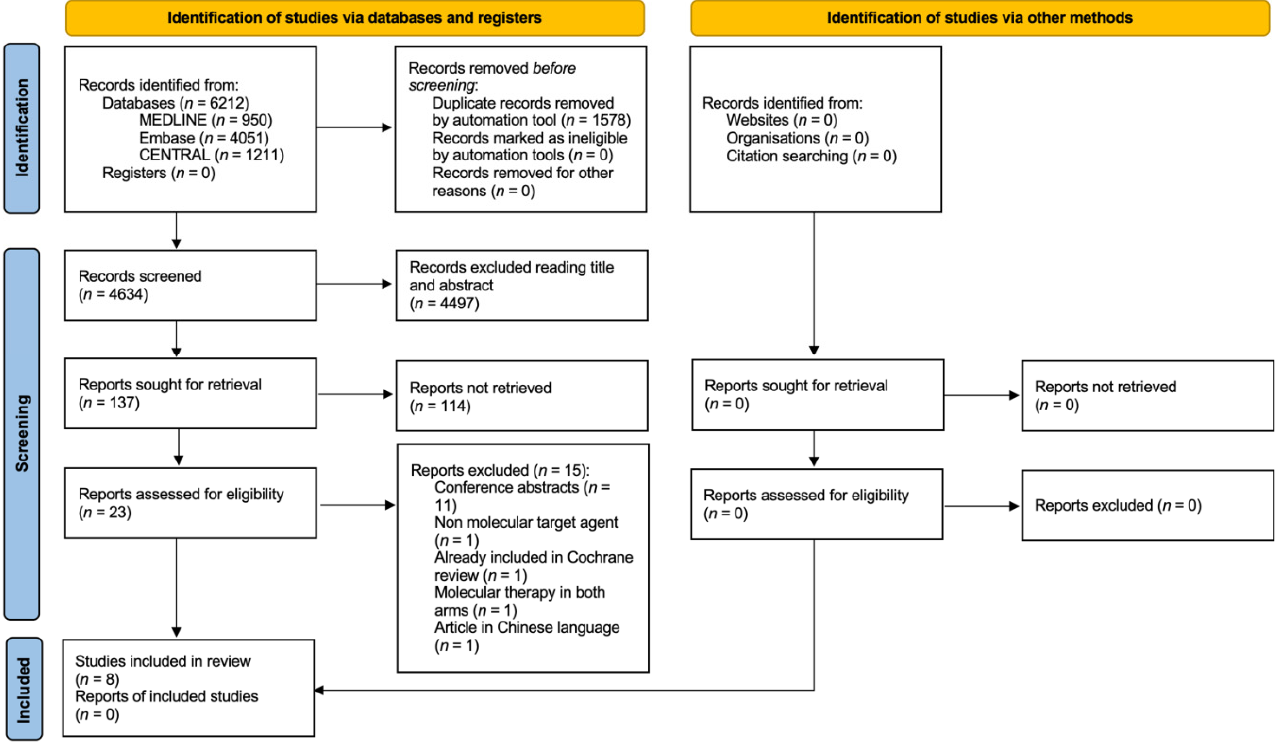
Figure 2. Prisma flow diagram .